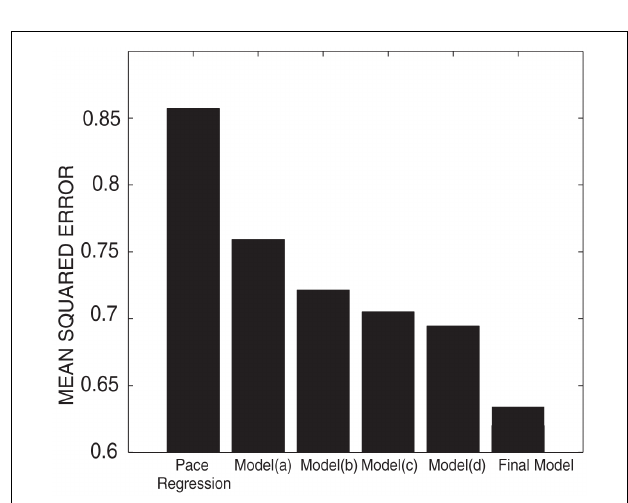
FIGURE 10 | Performance (given as mean squared error for pace regression, intermediate models (a–d), and the final